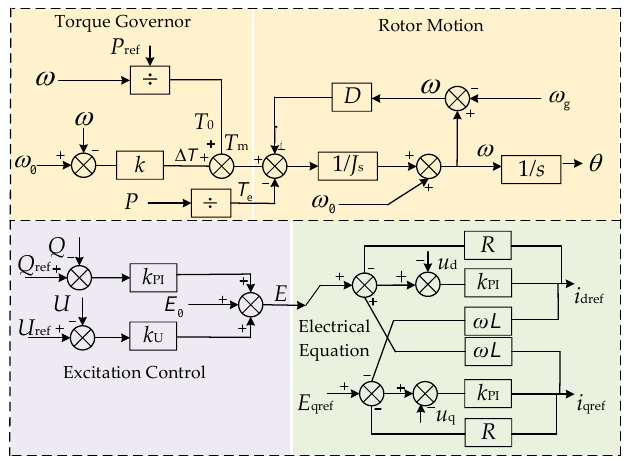
Figure 4. Control chart of virtual synchronous generator.